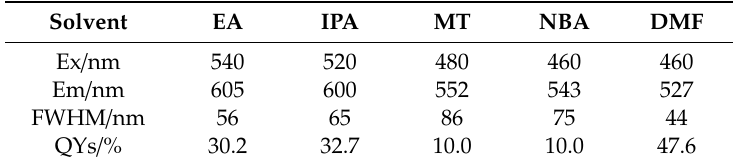
Figure 1. ( a ) The fluorescence and UV-vis spectra of carbon dots (CDs) synthesized by five different solvents. ( b ) A fluorescent ink color photo (365 nm) drawn by five CDs. Table 1. Excitation wavelength, emission wavelength, quantum yields (QYs), and full width at half maximum (FWHM) of carbon dots (CDs) synthesized by five different solvents.